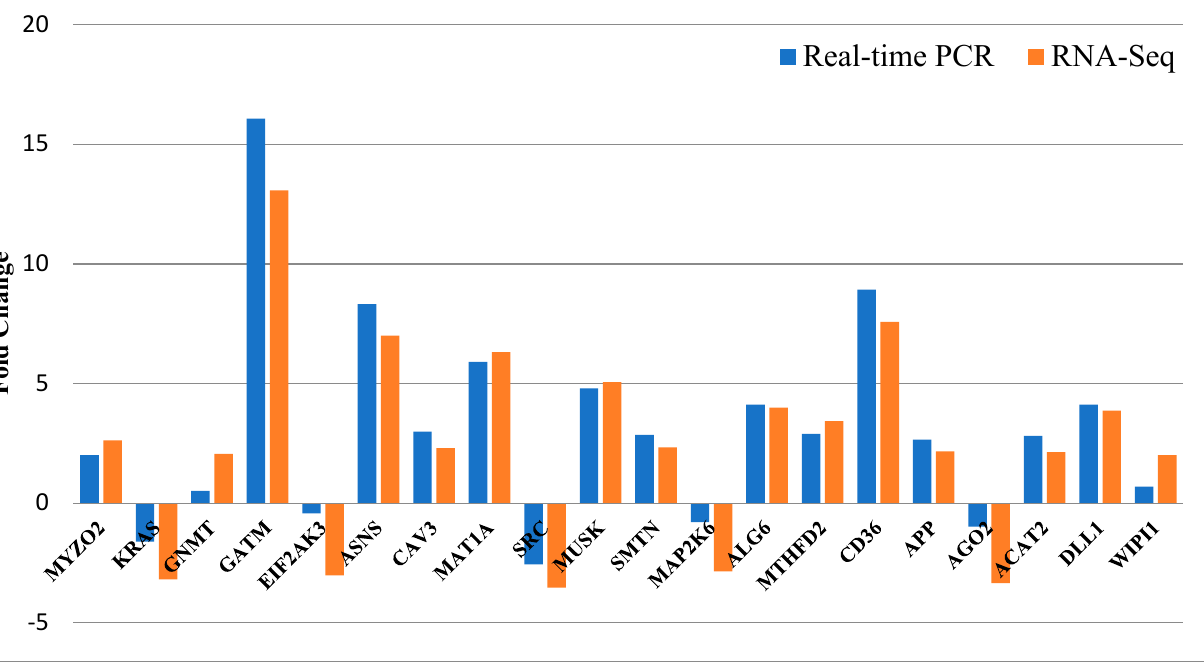
Figure 9. The results of qRT-PCR confirmation for 20 selected differentially expressed genes. The X -axis shows 20 selected genes for qRT-PCR assays, and the Y -axis demonstrates the log2 (fold change) derived from RNA-Seq and qRT-PCR .